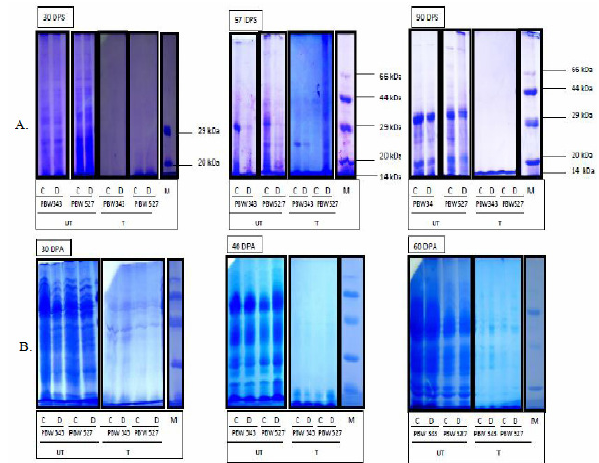
Fig. 3. An SDS PAGE profile of proteins in shoots (A) and seeds (B) of drought tolerant (PBW 527) and drought sensitive (PBW 343) cultivars of T. aestivum harvested at three different vegetative and reproductive stages : 30 DPS, 57 DPS, 90 DPS and 30 DPA, 40 DPA and 60 DPA respectively under control (C) and drought (D) conditions Each lane loaded with 60 µg of protein sample. DPS: Days Post Sowing. DPA: Days Post Anthesis. M: Molecular weight marker. UT- Untreated / Unboiled protein samples, T-Treated/Boiled protein samples.